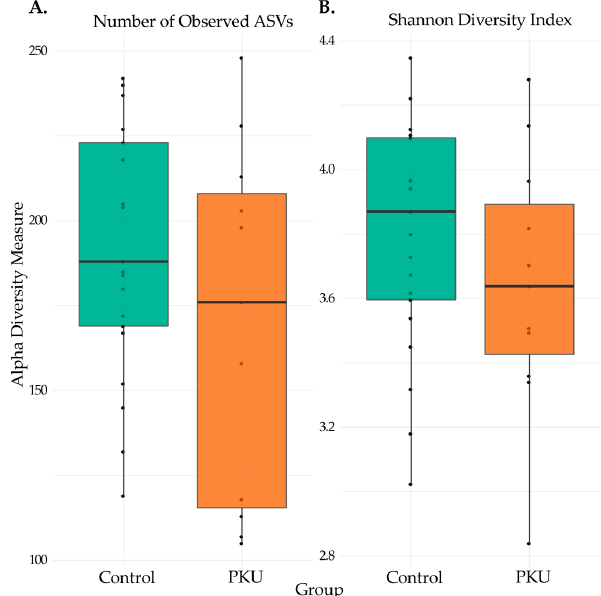
Figure 4. Alpha diversity for PKU and control samples. Statistical significance of the ( A ) number of observed ASVs and ( B ) Shannon diversity index from PKU and control samples were calculated and compared with the Wilcoxon rank-sum test. Median scores are represented with a horizontal line, the box outer limits represent the first to third quartiles, the whiskers indicate the range of measurements for each group, and each point denotes a sample. Observed ASVs (Wilcoxon: W = 143, p = 0.28) and Shannon index (Wilcoxon: W = 139, p = 0.37).